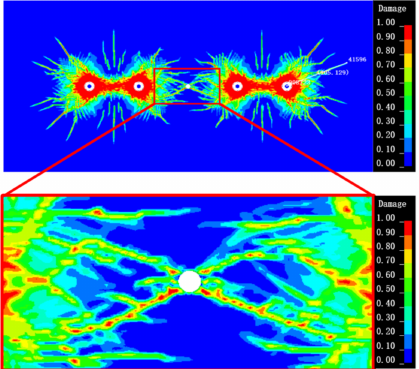
Figure 13. Engineering Blasting simulation